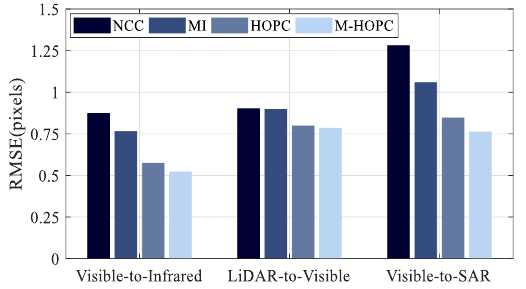
Figure 7. RMSEs detected in the template size of 100 ×100 pixels for the correct CP matches of the four similarity